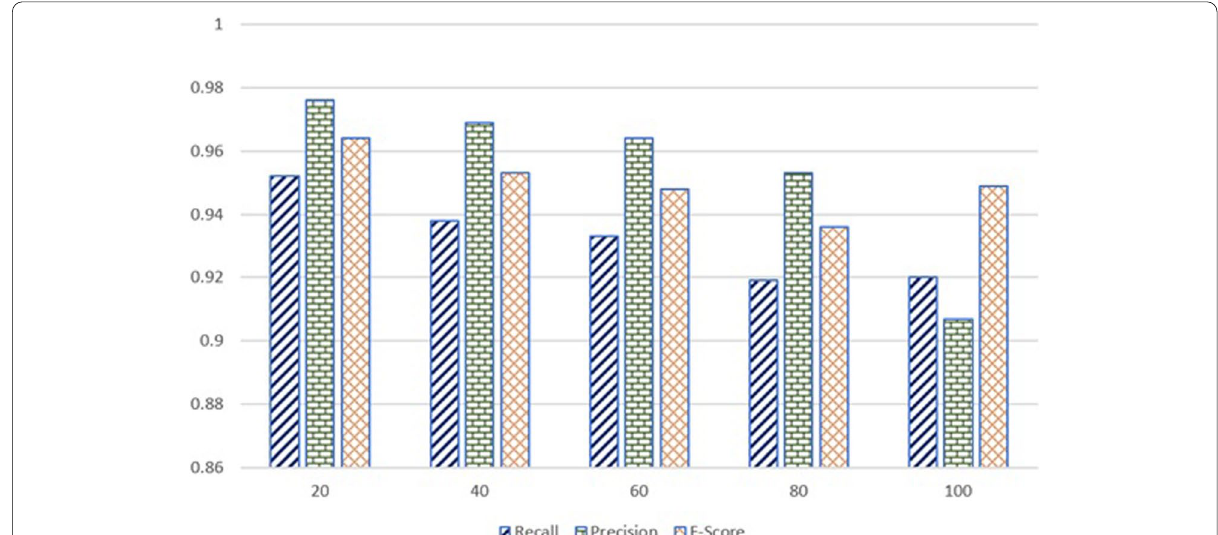
Fig. 6 Performance metrics with the incremental